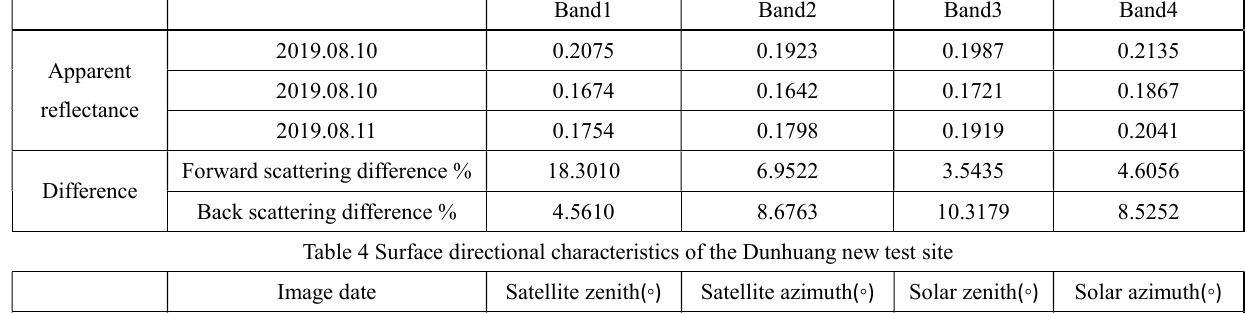
Table 4 Surface directional characteristics of the Dunhuang new test site